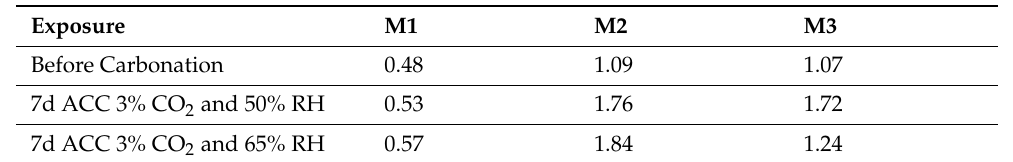
Table 4. Sorption coefficients (kg/(m 2 · h 0.5 )) before and after accelerated carbonation at 50% and 65% RH, 3 vol.% CO 2 , 20 ◦ C and ambient pressure, ACC = accelerated carbonation.